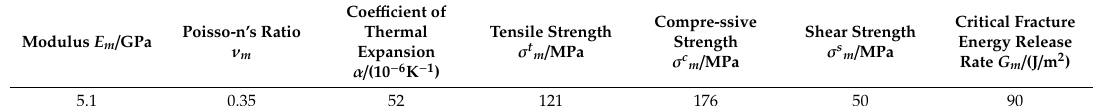
Figure 4. The schematic of damage initiation and evolution of the uniaxial tension-compression response for the epoxy resin. Table 2. Mechanical properties for 8552 epoxy